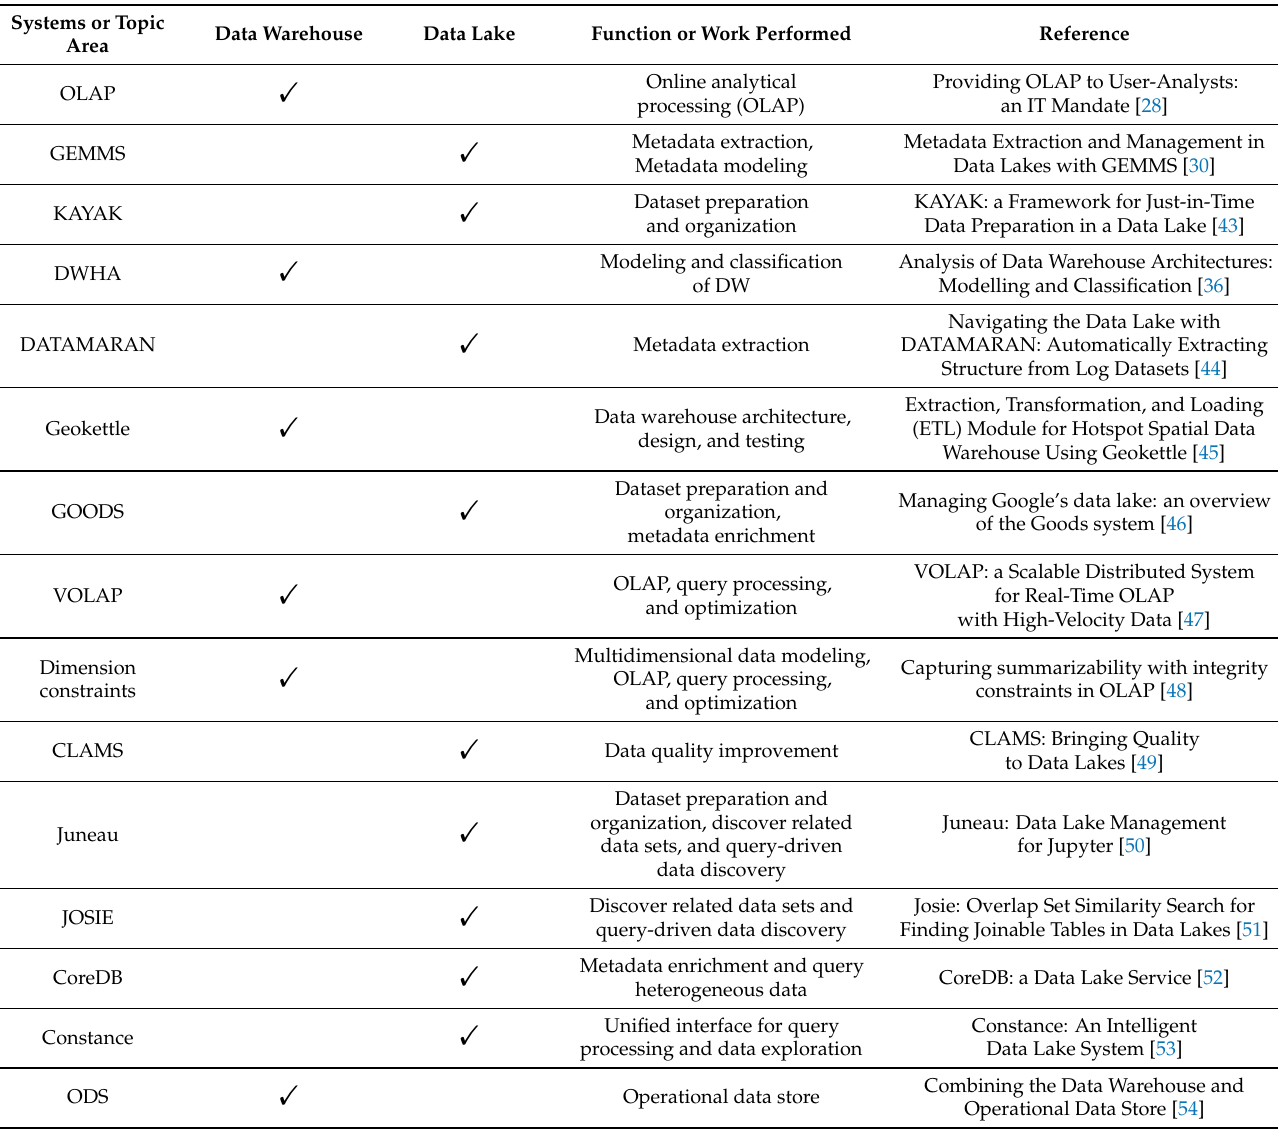
Table 3. Related works: classification of data warehouse and data lake